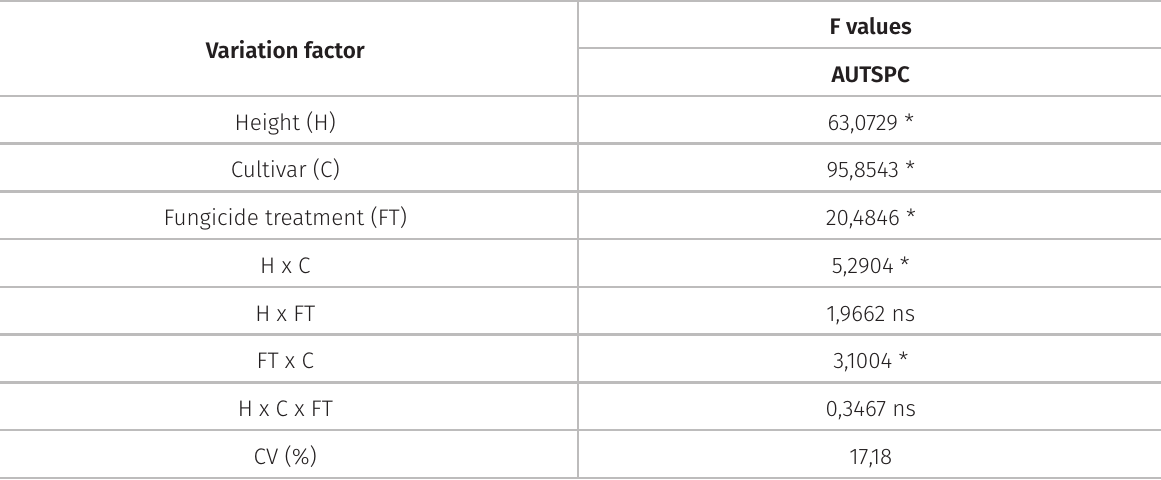
Table II. Analysis of variance of the area under the target spot progress curve (AUTSPC) in three cotton cultivars, two plant height and fungicide treatments. Chapadão do Sul, MS. Crop season: